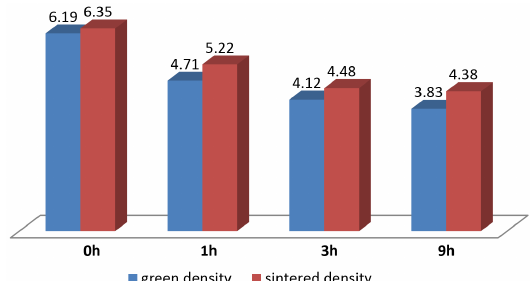
Figure 5. Green and sintered density of